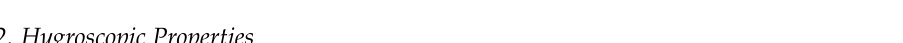
Figure 6. Microscopic images of the four formulations. Table 8. Maximum values of cob’s compressive strength versus Sargassum muticum seaweed content. Samples R0 R1 R2.5 R4 Compressive strength (MPa) 1.66 1.33 1.25